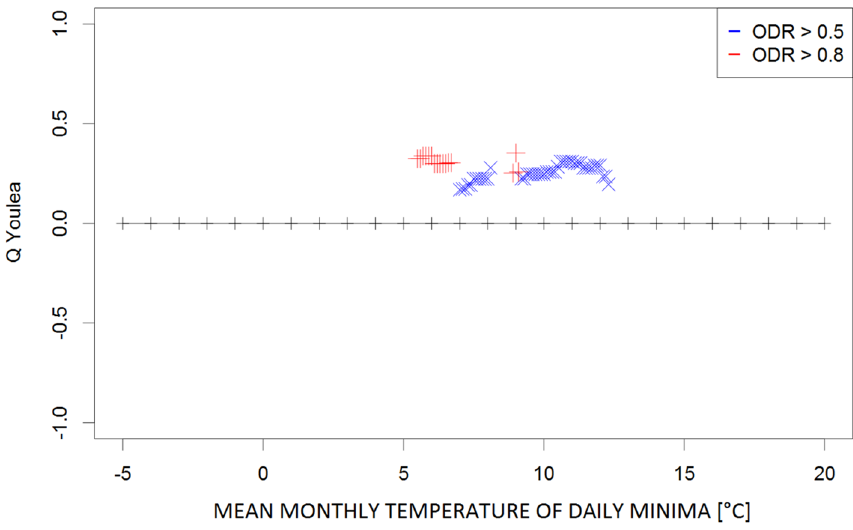
Figure 5. Plot of Q coefficients for different threshold levels of monthly temperature of daily minima (Tn) for the investigated ODR limits (≥ 0.5 and ≥ 0.8).